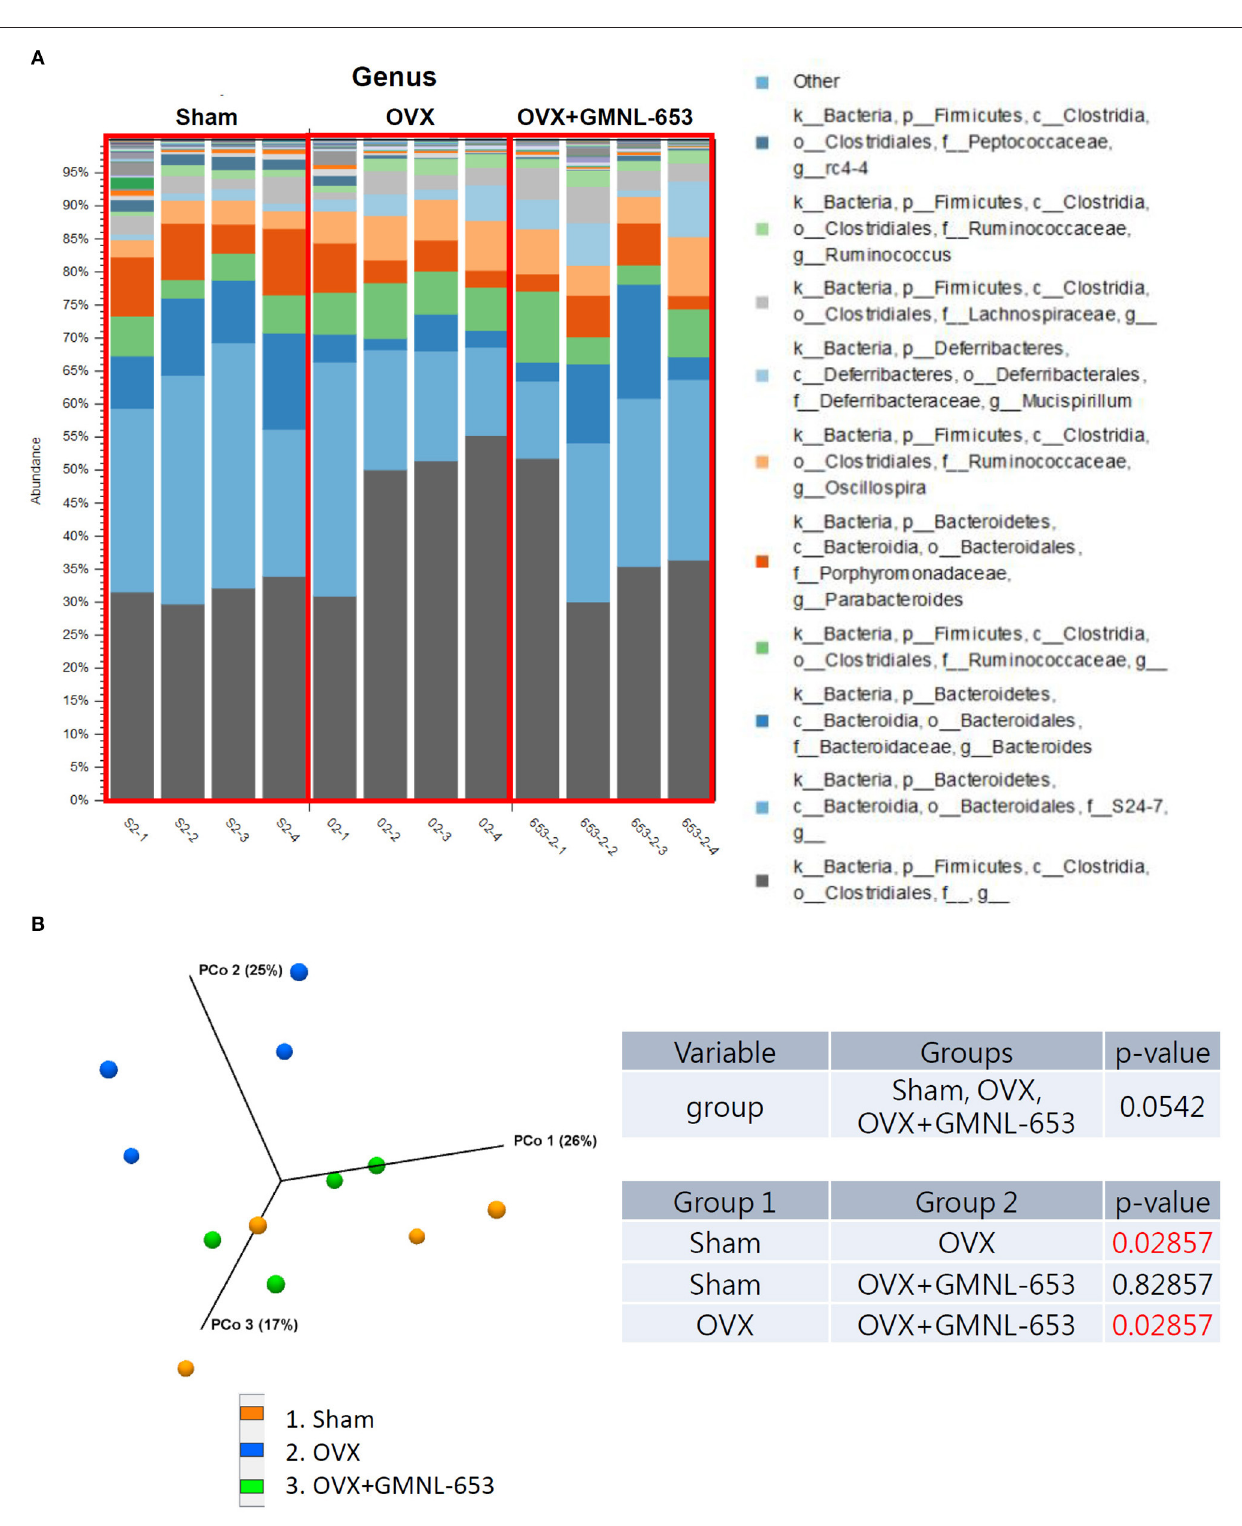
Frontiers in Nutrition |